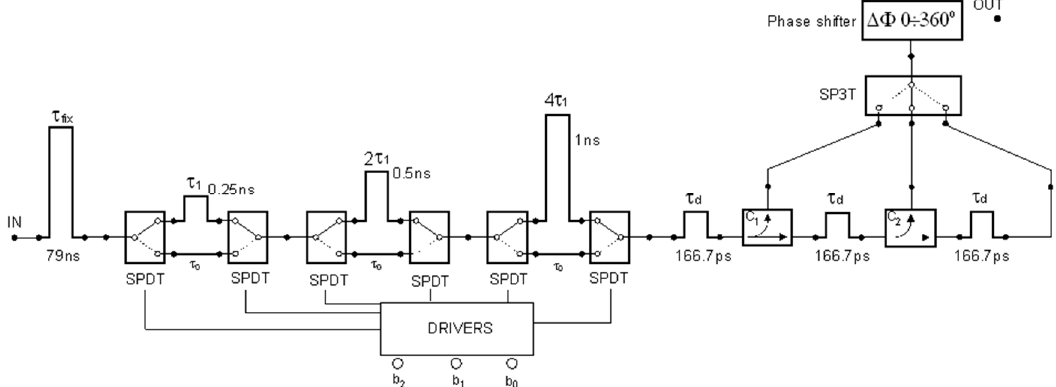
Figure 2. Example of a digitally-controlled delay line with a set of fine distance gates and an adjustable phase shifter for finding the optimal operating point of a correlation detector.